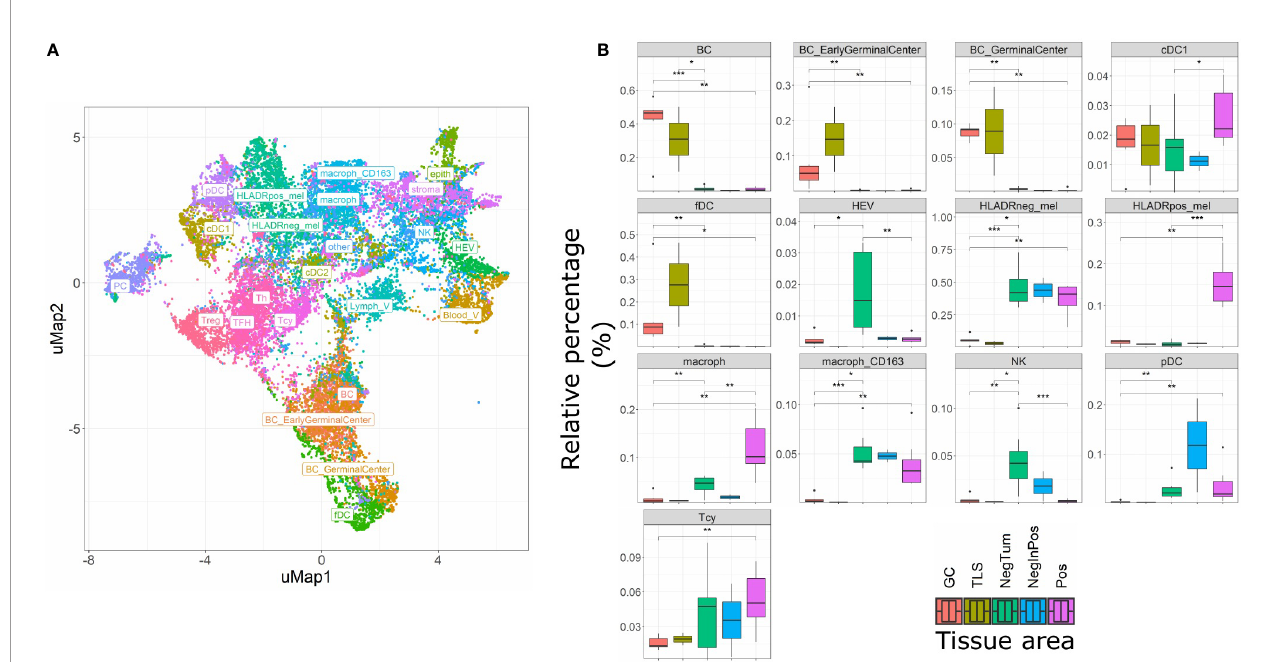
FIGURE 3 | Single cell composition of HLA-DR+ areas, HLA-DR- areas in positive tumors, HLA-DR- tumors, germinal centers and tertiary lymphoid structures. (A) uMap of a subset of cells (22,000) from the complete dataset included in this analysis (544,910 cells). BC= B cell not further speci fi ed; BC_EarlyGerminalCenter= Early germinal center B cell; BC_GerminalCenter= Germinal center B cell; cDC1 = Classical dendritic cell type I; fDC= Follicular dendritic cell; HEV= High endothelial venule; HLAneg_mel= HLA-DR negative melanoma cell; HLADRpos_mel= HLA-DR positive melanoma cell; macrop= Macrophage; macrop_CD163= CD163 positive macrophage; NK= Natural Killer cell; pDC= Plasmacytoid dendritic cell; Tcy= Cytotoxic T cell; Treg= Regulatory T cell; TFH = T Follicular Helper cells; Th= T helper cell; PC = Plasma cell; cDC2 = Classical dendritic cell type II; Stroma= Stromal cell; epith= Epithelial cell; Lymph_V= Lymphatic vessel; other= Cells not further speci fi ed. (B) Boxplots indicating the relative proportion of different cell-types in the different micro dissected areas, from left to right: ‘ GC ’ (Germinal center from reactive lymph nodes; orange), TLS (germinal centers from tertiary lymphoid structures, ochre), ‘ NegTum ’ (Tumour border of HLA-DR negative tumors, green), ‘ NeginPos ’ (HLA-DR negative area of HLA-DR positive tumors, blue) and ‘ Pos ’ (HLA-DR positive area of HLA-DR positive tumors, pink). Signi fi cance levels indicate: *p-value ≤ 0.05, **p-value ≤ 0.01, ***p-value ≤ 0.001. P-values are derived from Wilcoxon tests (not fdr